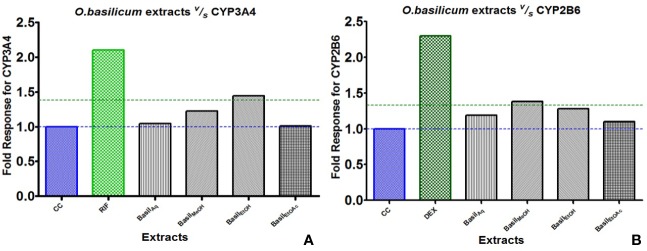
Graphs of the herbal extracts and their fold responses for CYP3A4 and 2B6 mRNA expression, relative to cell control (CC); rifampicin (RIF) and dexamethasone (DEX) as positive controls, (A, B) respectively.